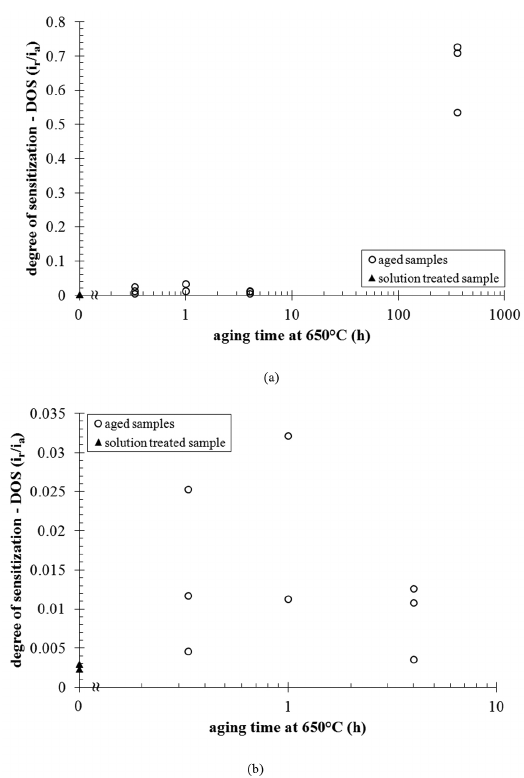
Figure 7. Degree of sensitization (DOS) in 1 M H NaCl + 0.01 M KSCN solution for samples aged at 650°C compared to the solution treated sample: (a) samples aged up to 360 h; (b) samples aged up to 4